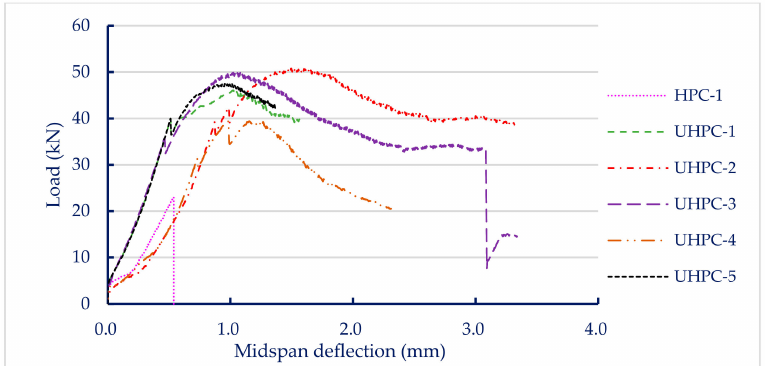
Figure 3. Load–deflection curves of concrete specimens.